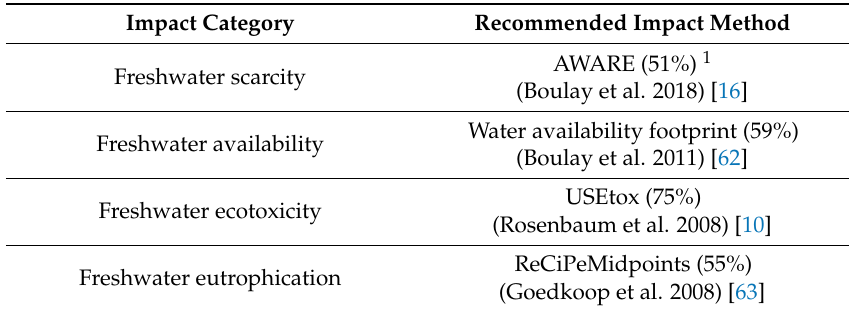
Table 4. Recommended impact assessment methods for water footprint studies in Latin America. Modified from CADIS-COSUDE (2016)